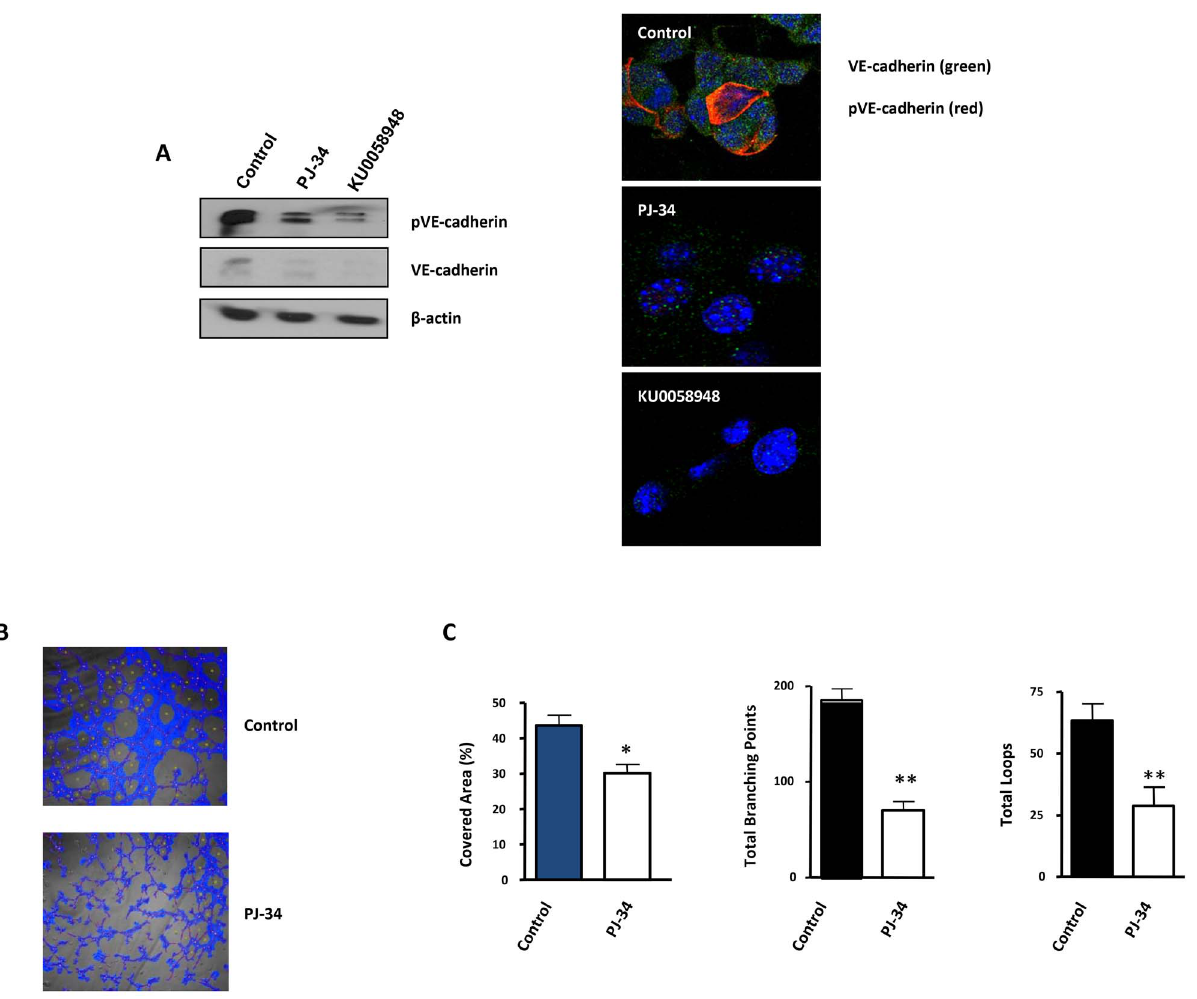
Figure 6. Vasculogenic mimicry is reduced by PARP inhibition in cells and in xenogafts of malignant melanoma. ( A ) Western-blot and immunofluorescence of VE-cadherin and pVE-cadherin in B16-F10 cells treated with PJ-34 or KU0058948. ( B, C ) B16-F10 cells were cultured on polystyrene-treated culture slides and treated with the PARP inhibitor PJ-34 at 20 m M or left untreated. Following treatment, pictures were taken and analyzed using Wimasis image analysis software. ‘‘Branching points’’: crossroads from at least three ‘‘branches’’. ‘‘Loops’’: Closed areas surrounded by cells. Four independent experiments were performed (* P , 0.05; ** P , 0.01).